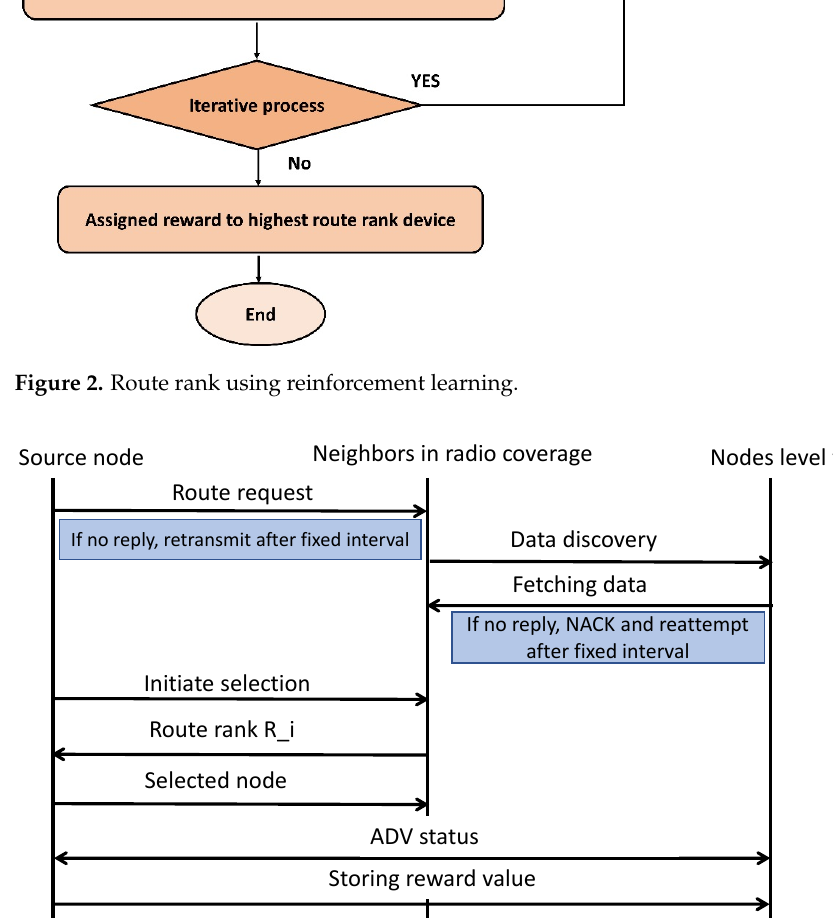
Figure 3. Next-hop selection procedure.